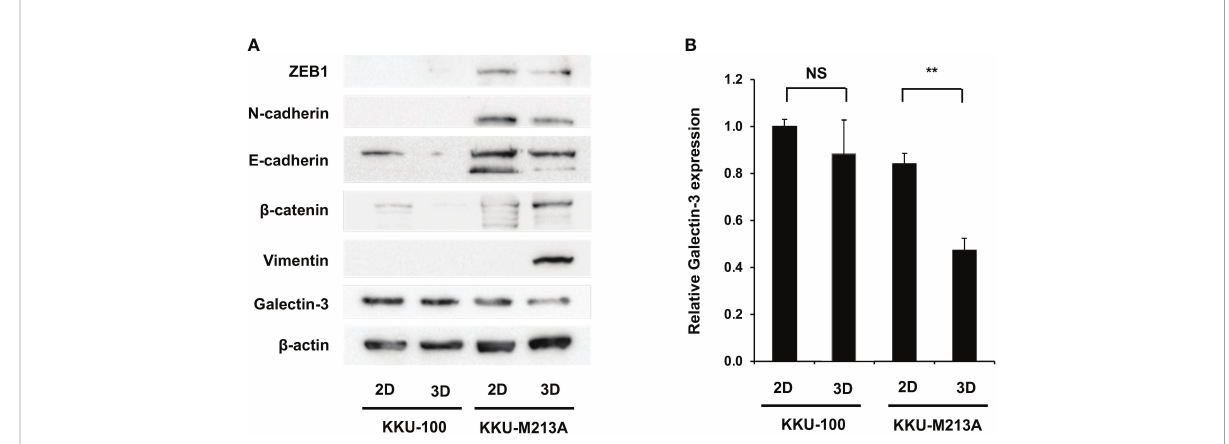
FIGURE 3 Migration-related expression in CCA cells in 2D and 3D culture systems. (A) CCA cells were grown as monolayers and spheroids for 6 days. Cells were harvested and lysed. Protein expression was determined by Western blotting. Migration-related proteins were compared between the two culture systems in each cell line. b -actin was used as an internal control. (B) Expressions of galectin-3 was quanti fi ed as relative intensity to b -actin. The data represent means and ± standard error. ** p < 0.01, NS represents not signi fi cant.